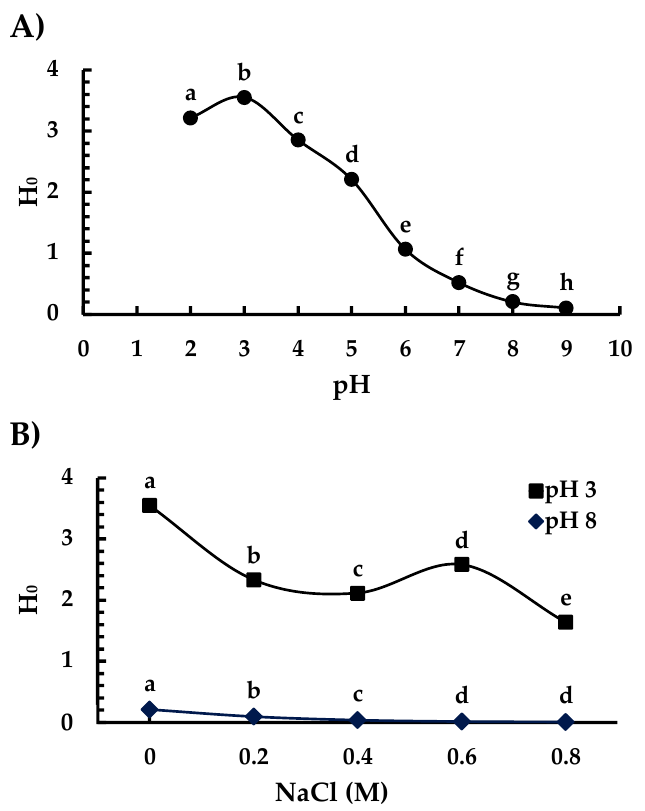
Figure 6. Surface hydrophobicity indices of Ah11Sn at different pH values ( A ) and concentrations of NaCl ( B ). The different letters at different pH values ( A ) or pH 3 or 8 ( B ) indicate significant differences at p < 0.05.